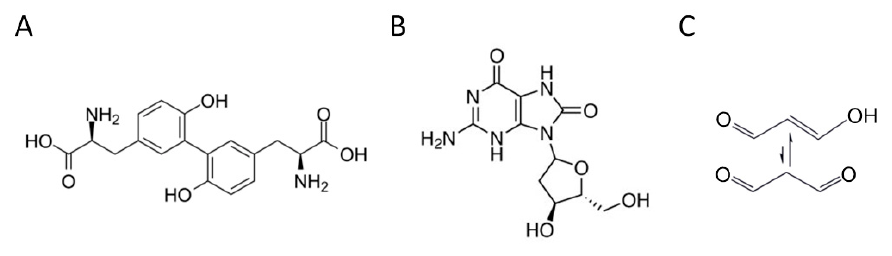
Figure 1. Chemical structure of the main representative oxidative stress biomarkers in urine. ( A ) o,o’-dityrosine (diY); ( B ) 8-hydroxy-2 ′ -deoxyguanosine (8-OHdG); ( C ) malondialdehyde